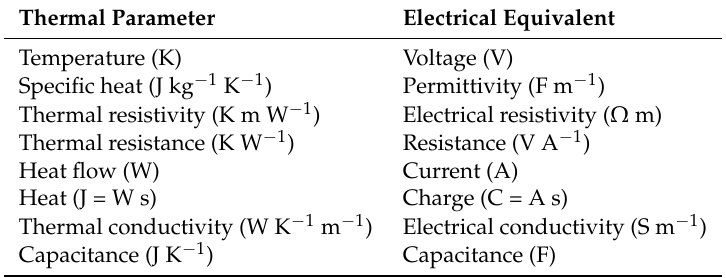
Table 3. Thermal to electrical parametric conversion for lumped thermal network simulations using the Cauer